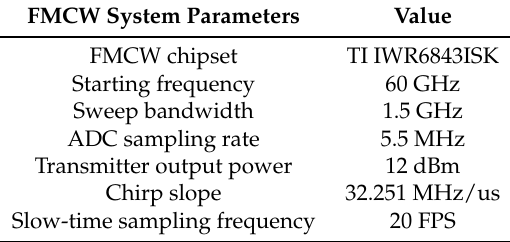
Table 2. FMCW Radar